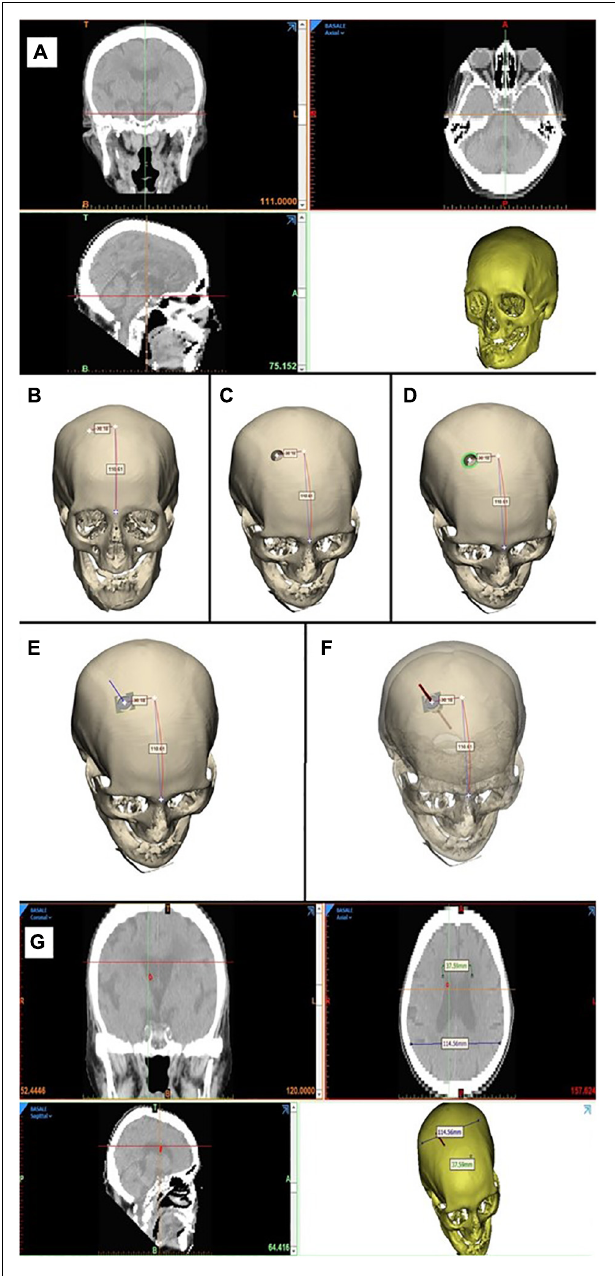
FIGURE 4 | 3D computer-based simulation (A) , showing the entry point definition based on anatomical landmarks, to both the right and left, Evans’ evaluation, simulation of the catheter placement (B–F) , bilaterally obtaining grade A positioning (G) .